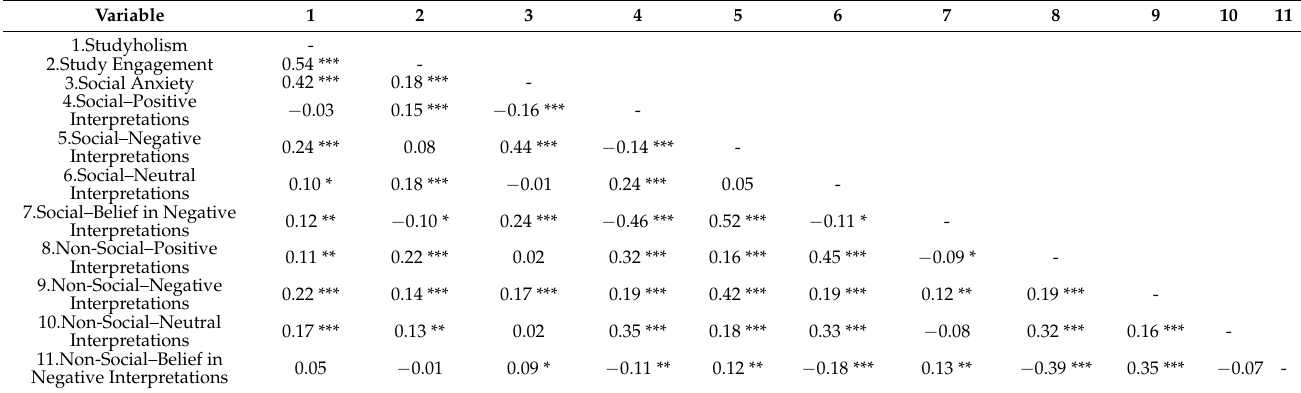
Table 2. Zero-order correlations for study variables ( n =